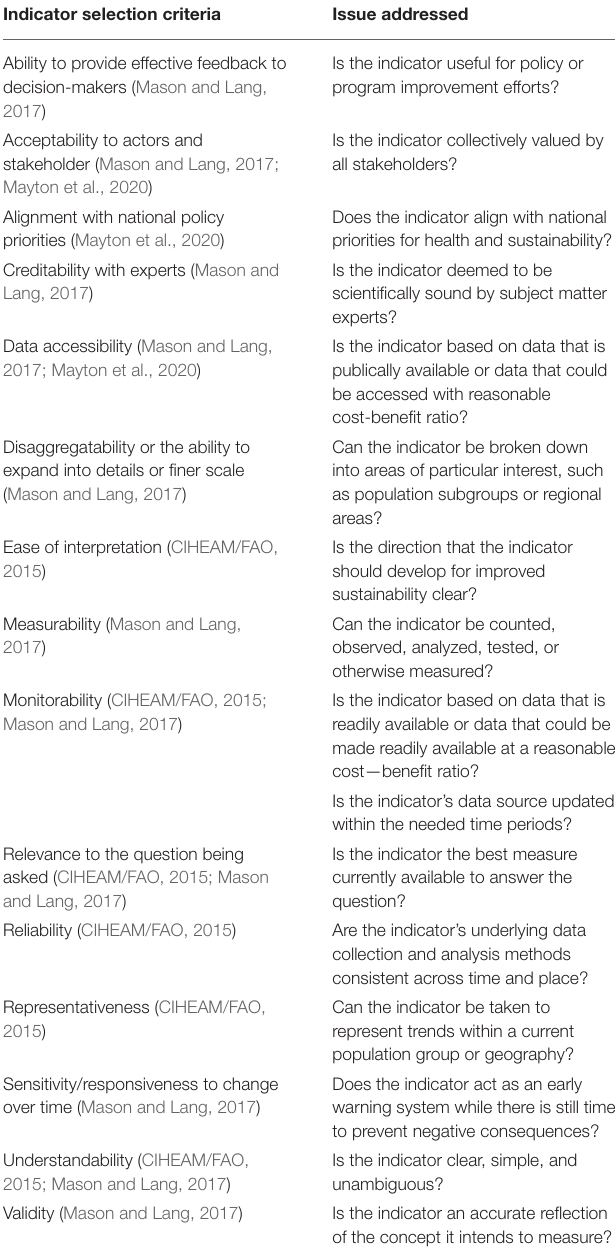
TABLE 5 | Examples of criteria used for selecting sustainable healthy diet indicators (CIHEAM/FAO, 2015; Mason and Lang, 2017; Mayton et al., 2020). Indicator selection